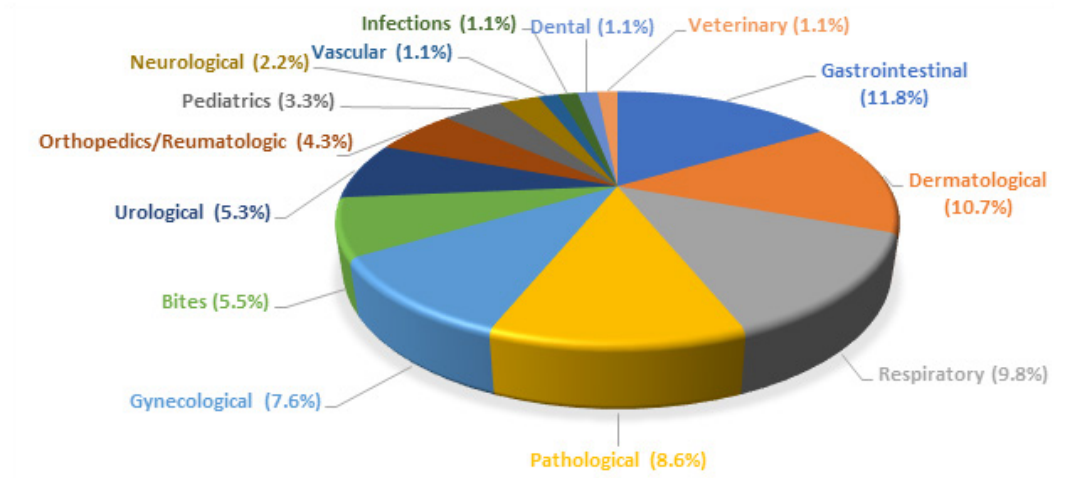
Figure 2. Distribution of native and cultivated plant taxa mentioned in literature by disease